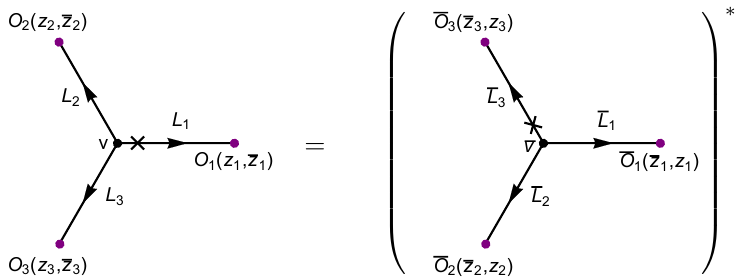
Figure 4 . Conjugation map in a correlation function. Here, O i with i = 1 ; 2 ; 3 denote defect operators in H L , and O i (cid:17) (cid:19) ( O i ) denote their conjugates, which are defect operators in H i